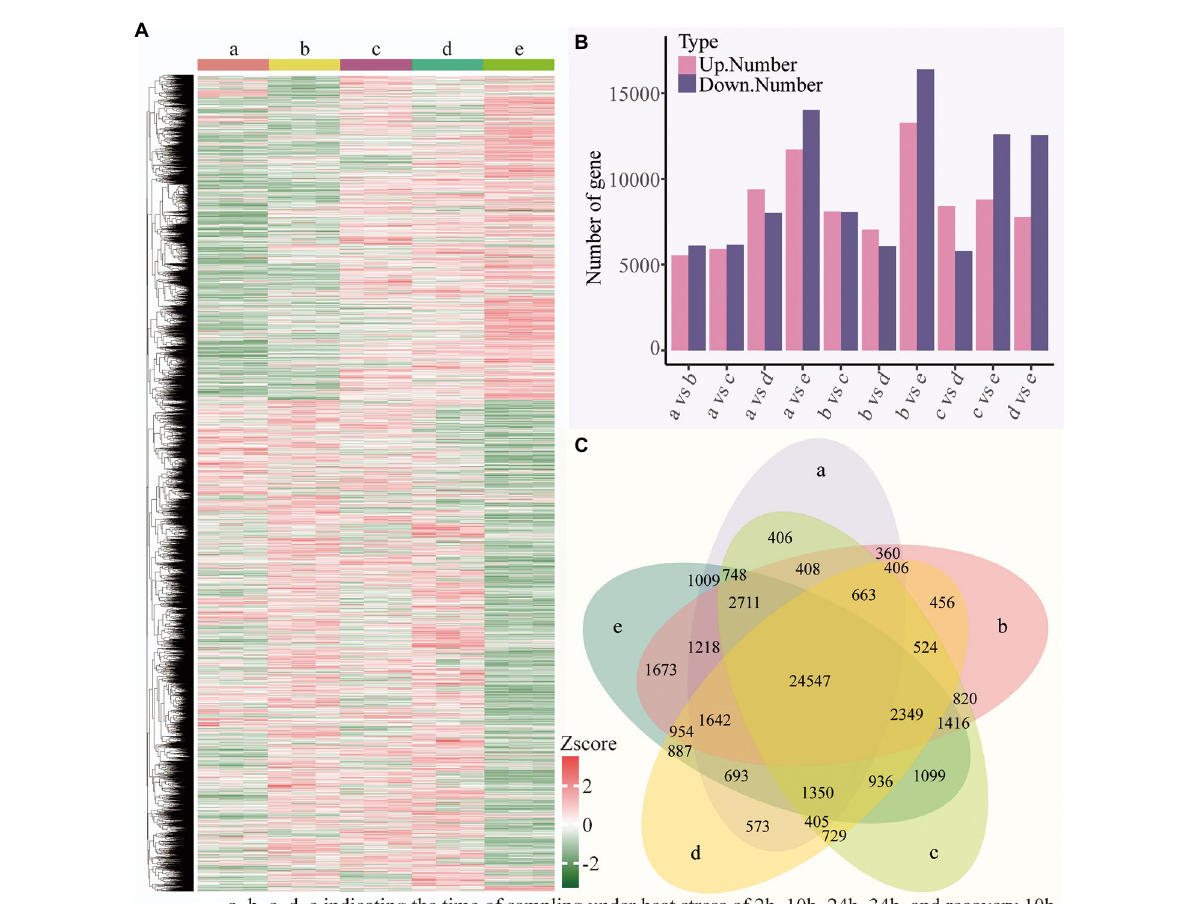
FIGURE 7 Transcriptional variations in B. luminifera under different treatments time period. (A) Hierarchical clustering analysis of the DEGs under different treatments time period. (B) The number of up- and down-regulated genes in different treatments time period. (C) Venn diagrams showed the proportions of the DEGs in different treatments time